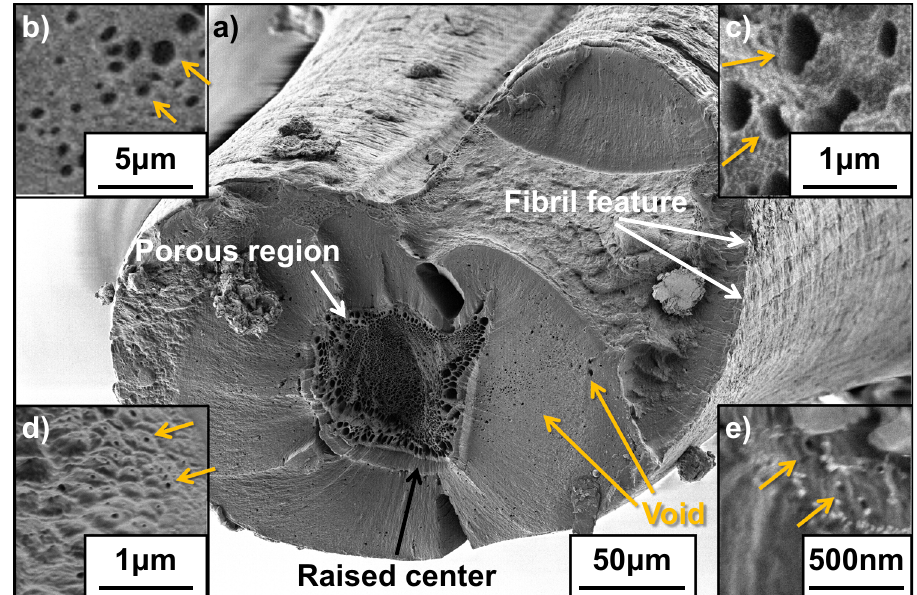
Fig. 1 A variety of porous region related mesoscale structures are observed in natural and arti fi cal silk fi bres. Formation of mesoscale structures in a partially spun regenerated silk fi bre, featuring a porous region in a raised central area and sub-micrometre scale voids ( a ). Void structures are identi fi ed by orange arrows. As an example of the generality of our observations, a magni fi ed area of this sample ( b ) is compared with similar porous regions and nano fi brillar structures present in cryo-cross sections of native Antheraea mylitta ( c ) and the outer edge ( d ) and central region ( e ) of Antheraea pernyi silk. While indicative, it is worth noting the diversity, scale and distribution of these mesoscale structures are likely to be speci fi c to each species and spinning conditions, much like fi bre mechanical property variation on an intra and interspeci fi c level.